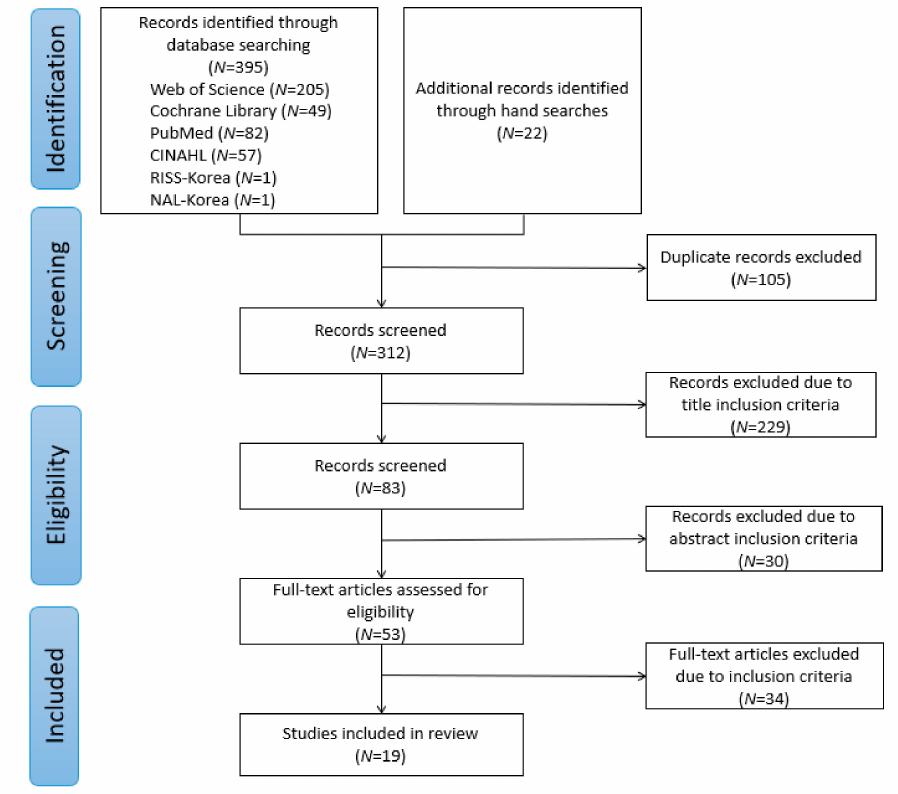
Figure 1. Flow diagram of study